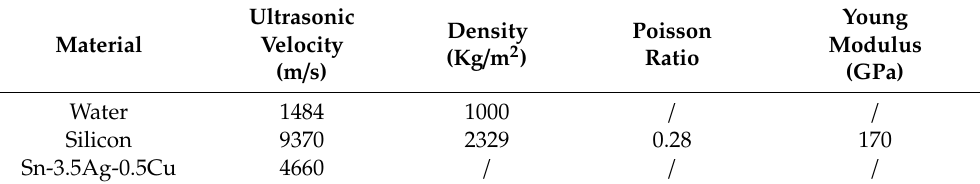
Table 1. Relevant parameters of simulation materials.